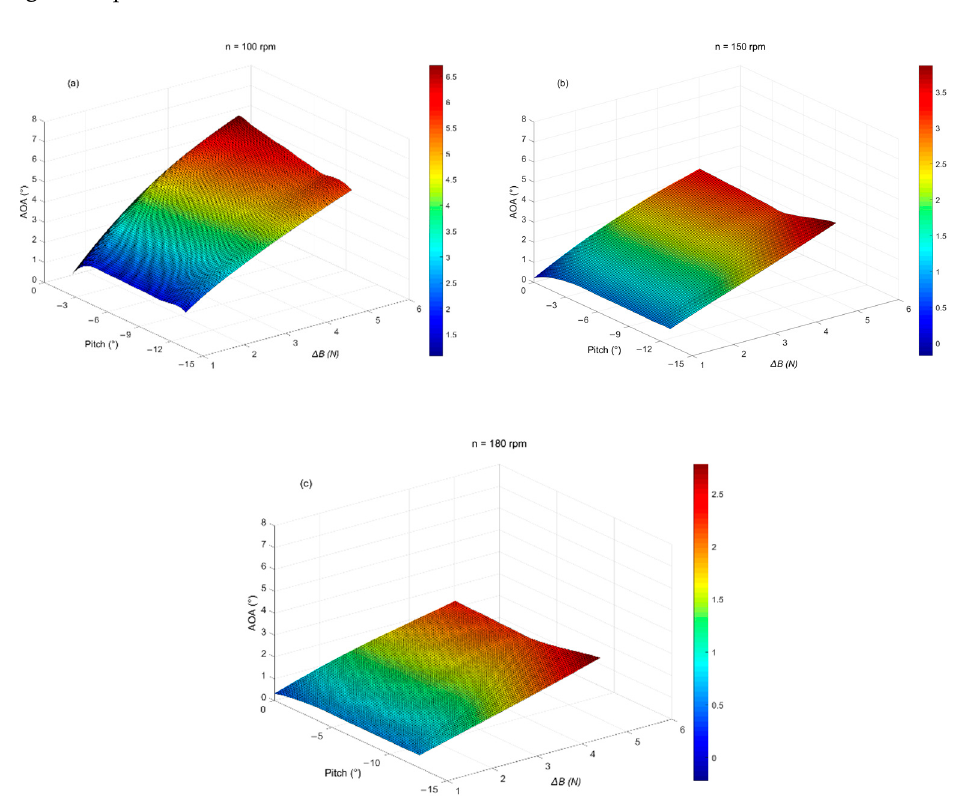
Figure 10. Relationship among AOA, net buoyance ( ∆ B ), and a pitch angle of turbulence AUV under different propeller speeds. ( a ) n = 100 rpm, ( b ) n = 150 rpm, ( c ) n = 180 rpm. In detail, we set F T = 6 N, ∆ B = 1 N, and θ = 12 ◦ and carried out simulation analysis on motion depth, pitch angle, angle of attack, and running speed in the yo-yo profile. The results are shown in Figure 11. According to Figure 11a, within the simulation time of the 1200 s, the maximum running depth of turbulent AUV is 100 m, and the corresponding horizontal sailing distance is about 853 m. The steady speed of the turbulent AUV is 0.73 m/s (Figure 11d). In Figure 11b,c, the pitch angle is − 11.5 ◦ and the AOA is 1.7 ◦ in the descent. The pitch angle is 11.7 ◦ and the AOA is 1.6 ◦ in the